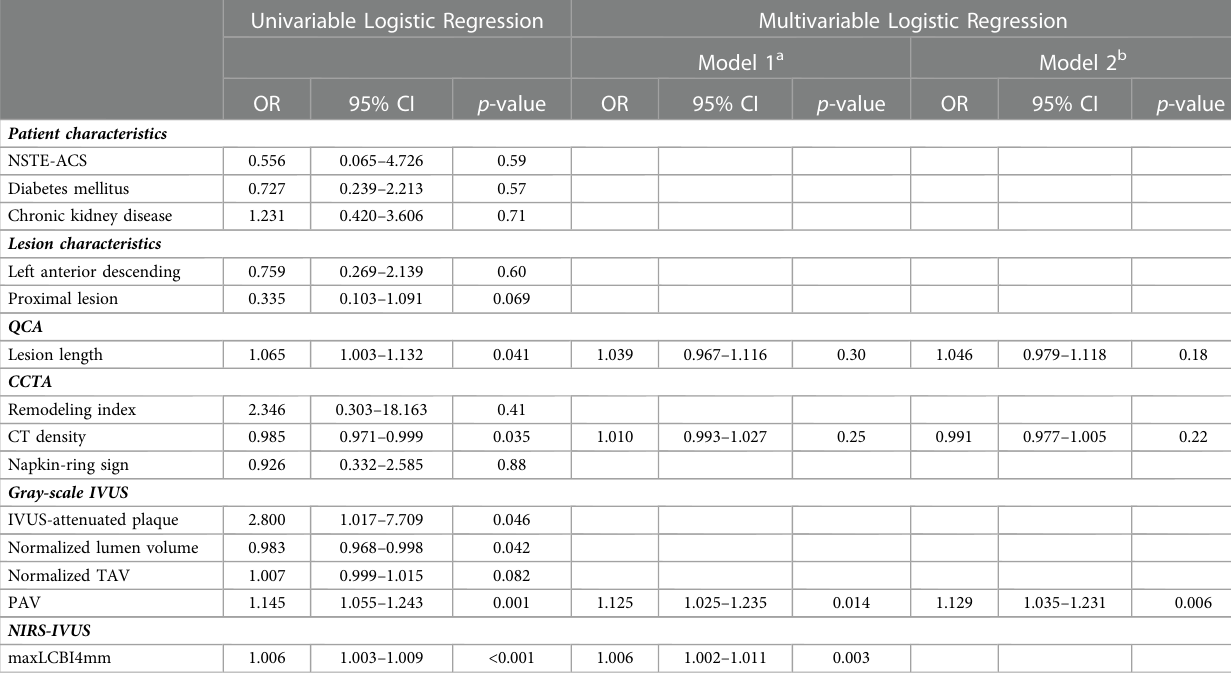
TABLE 4 Analysis of factors related to periprocedural myocardial